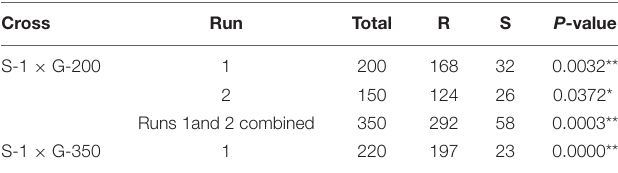
Significantly different at ** p ≤ 0.01, * p ≤